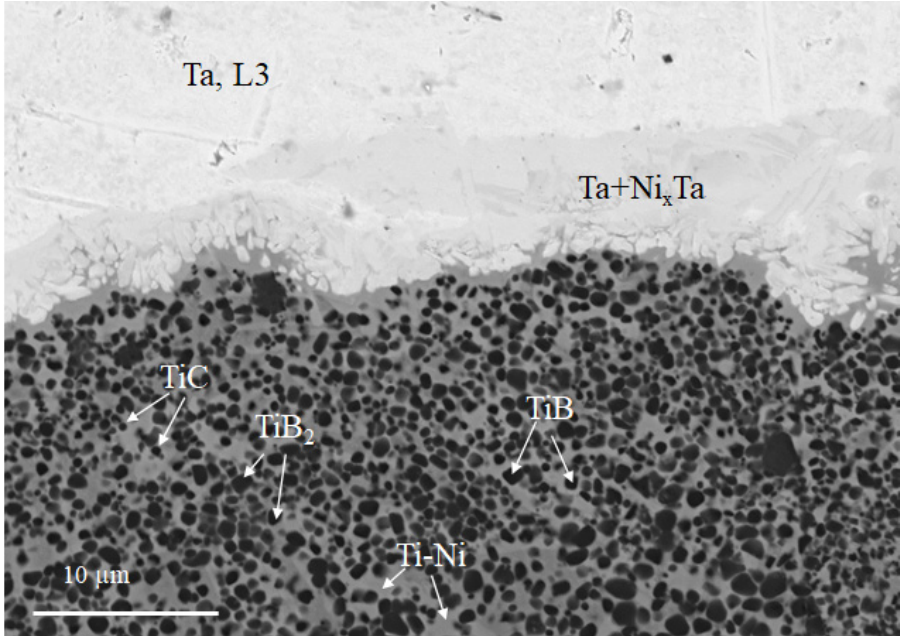
Figure 7. Microstructure of Ta–cermet composite formed upon combustion in zone L3–(L4–L6), cross section of burned Set 1 .